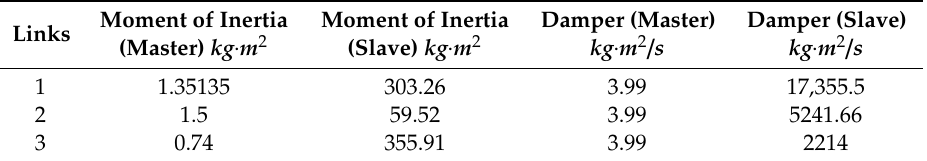
Table 2. Hydraulic manipulator dynamics